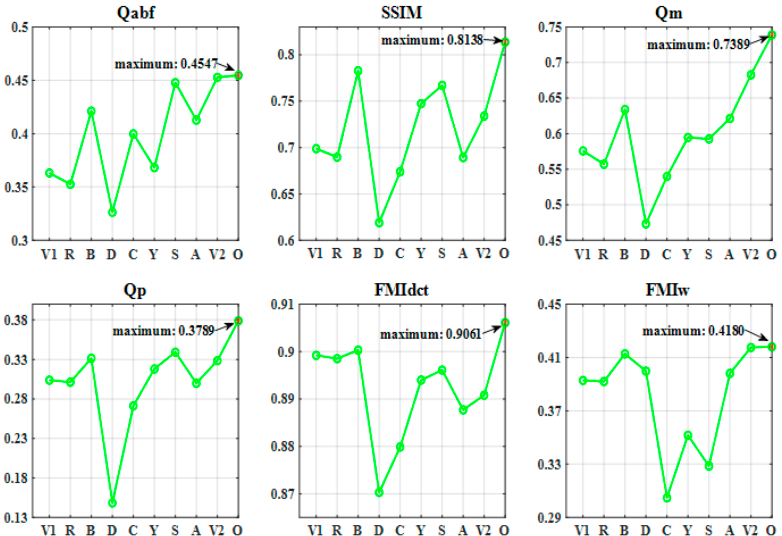
Figure 6. Average values of the six objective indicators for 30 sets of images from the TNO dataset. Here, V1, R, B, D, C, Y, S, A, V2, and O denote VggML, Resnet50, BayF, DDcGAN, CSF, YDTR, SeAFusion, AUIF, VEHMD, and Ours, respectively.